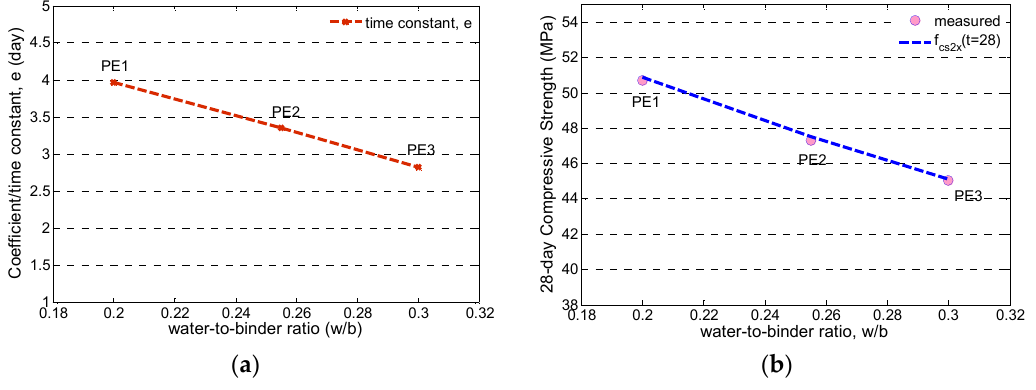
Figure 11. ( a ) Regression coefficient (time constant), e versus w / b ; ( b ) comparison of the 28 ‐ day strengths: measurement, regression values using (5).